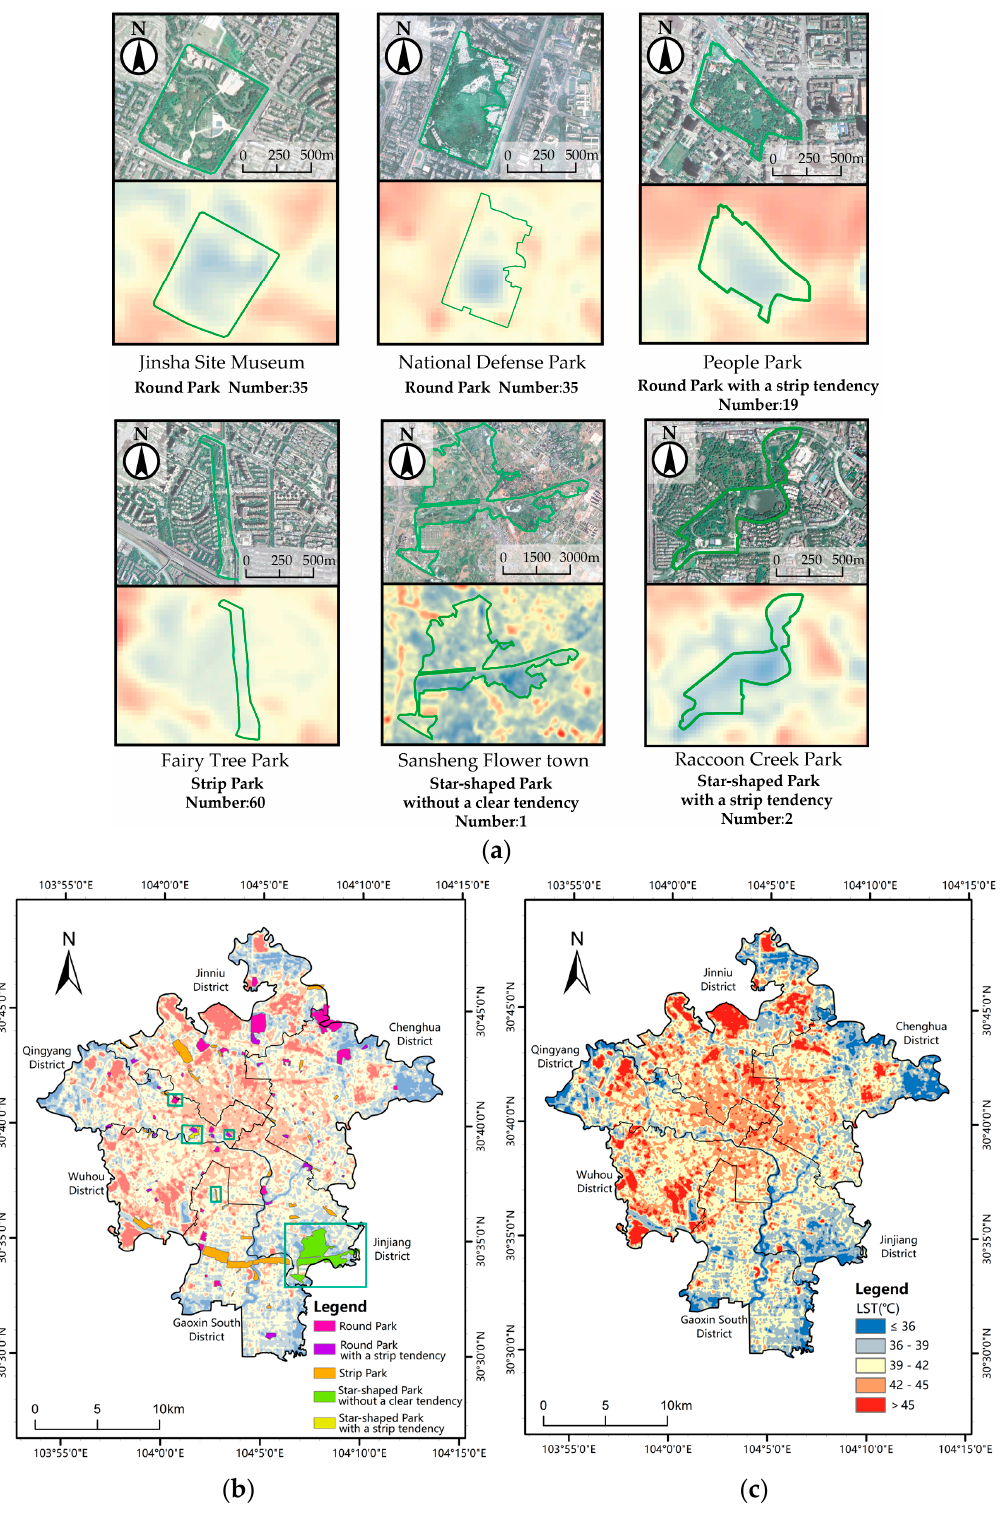
Figure 3. ( a ) Six samples of park forms; ( b ) classification of 117 park forms; ( c ) temperature pattern in Chengdu on 11 August 2019.